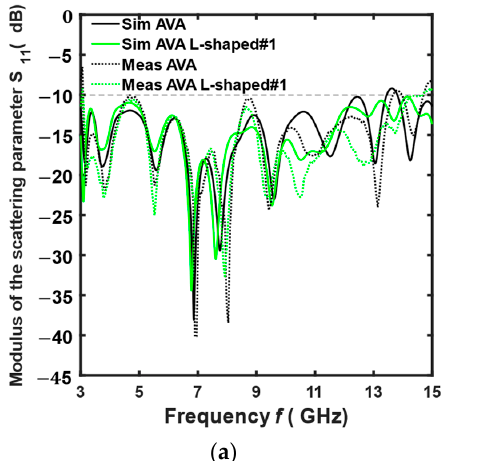
Figure 15. Measured E-plane (solid curve) and H-plane (dashed curve) half-power bandwidth of AVA (black curve) and AVA L-shaped#1 (green curve) as a function of frequency.